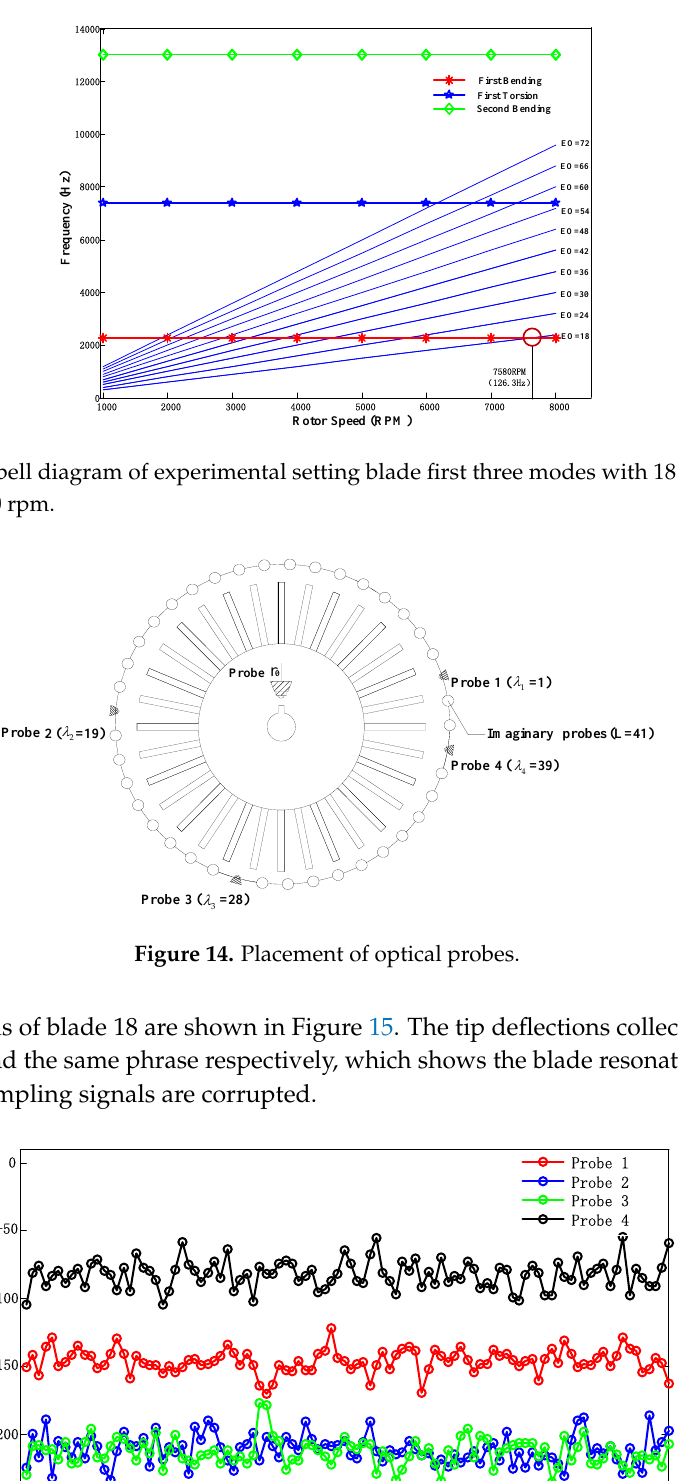
Figure 12. The test rig.